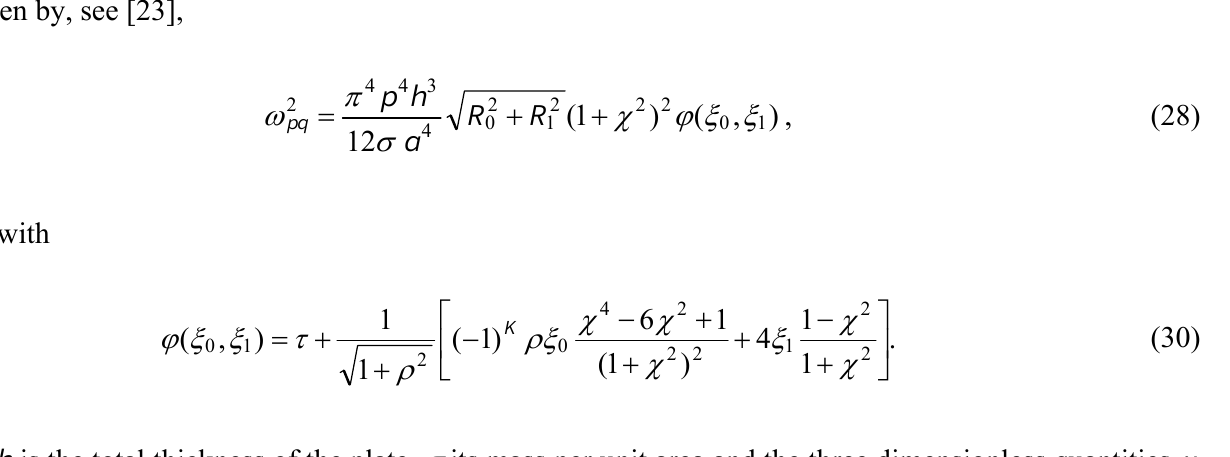
* , reduced to a dot xx